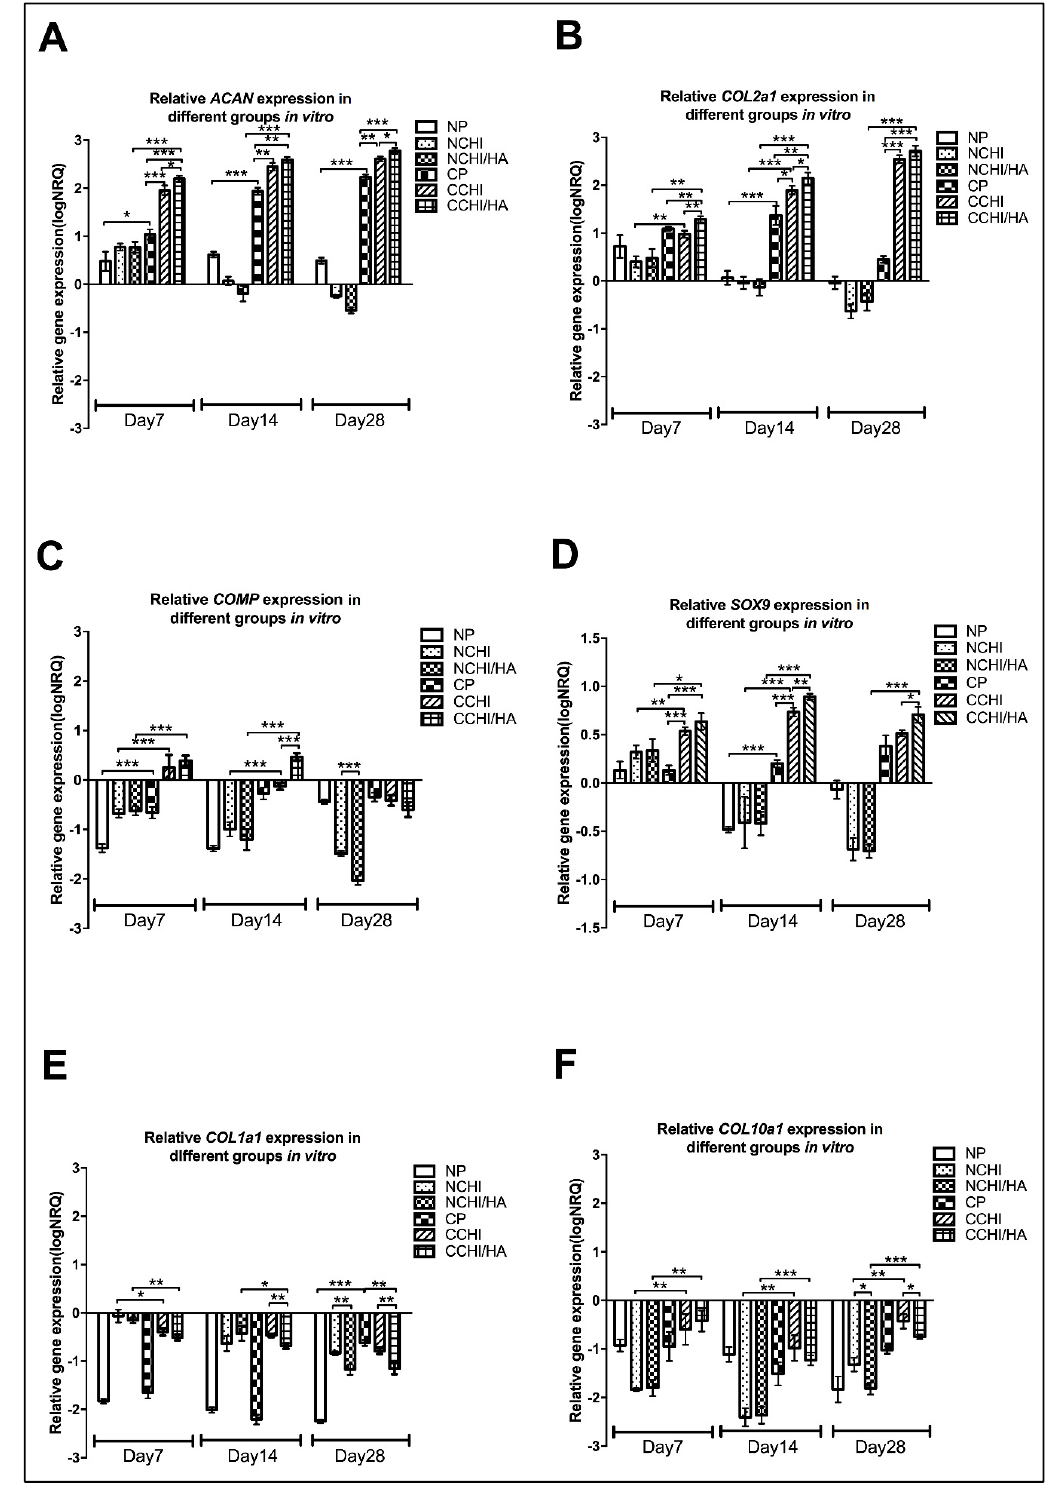
Figure 8. Relative quantitative gene expression of ( A ) ACAN , ( B ) COL2A1 , ( C ) COMP , ( D ) SOX9 , ( E ) COL1A1 , and ( F ) COL10A1 on Day 7, 14, and 28 for di ff erent culture groups (N = normal medium; C = chondrogenic medium, P = 3D Pellet; CHI = chitosan sca ff olds, CHI / HA = chitosan with hyaluronic acid sca ff old; * p < 0.05, ** p < 0.01, *** p < 0.001). The baseline 0 represents untreated hADSCs in the monolayer, which was the normalization